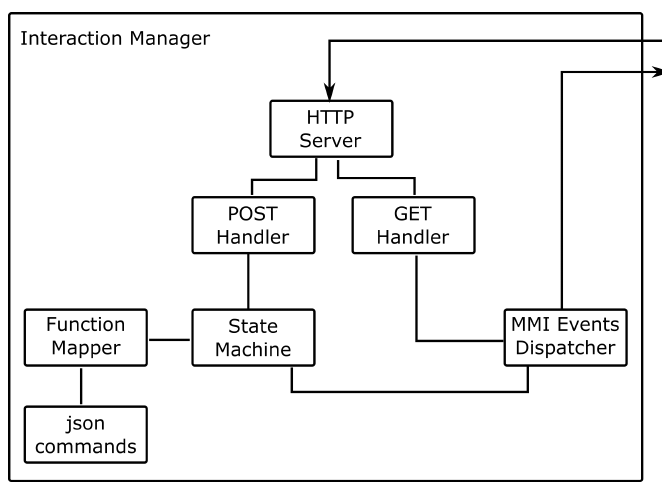
Figure 5. Main internal components of the Interaction